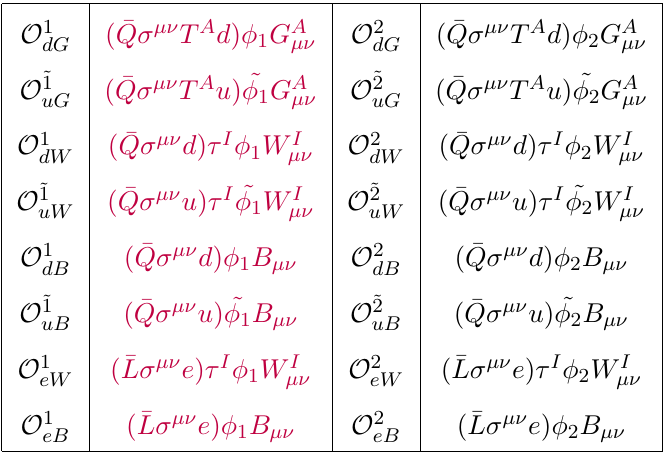
Table 7. 2HDM: 2 (cid:30)X [16 2 = 32] class of operators. Each of these operators also has a distinct (cid:2) Hermitian Conjugate.